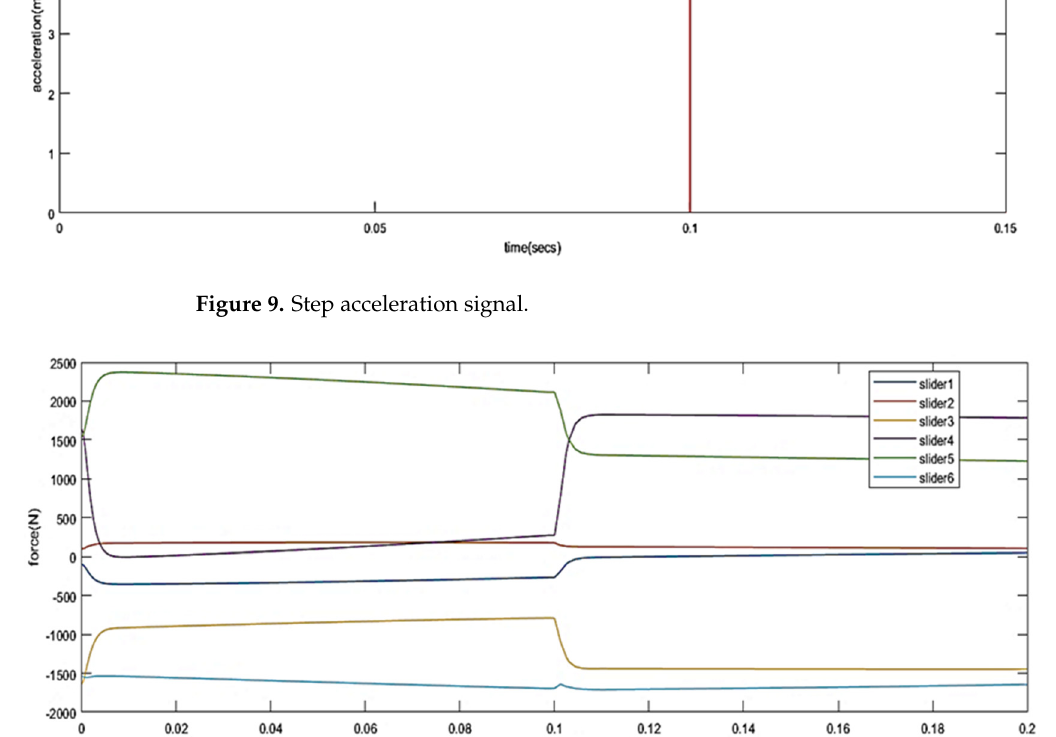
Figure 10. First dynamic simulation result.